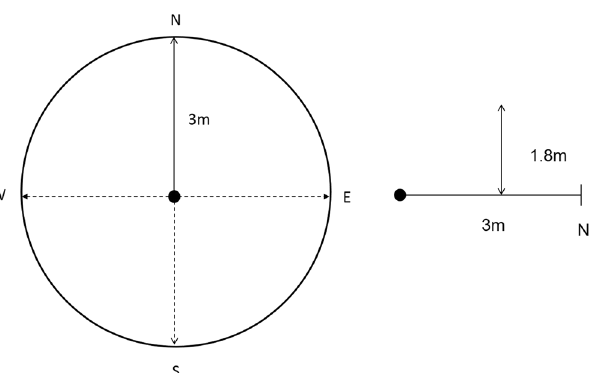
Figure 3. Representative rattan abundance measurement protocol. All rattan stems encountered along a 3 m long by 1.8 m high transect facing north were counted unless they were noted to arise from a previously encountered rattan clump. In addition, each counted rattan stem was classified as ≤ 3 m or > 3 m in height/ length. This procedure was then repeated for identical transects facing the other three cardinal directions with all transects originating from a central point. Finally, this entire process was repeated in the remaining three corners of each plot and the 16 transect values summed to gain an overall representative value of rattan abundance per 20 m 2